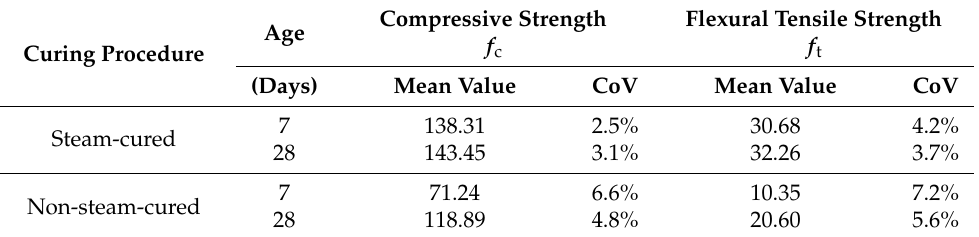
Table 3. Compressive strength and tensile strength of non-steam-cured and steam-cured UHPC specimens.